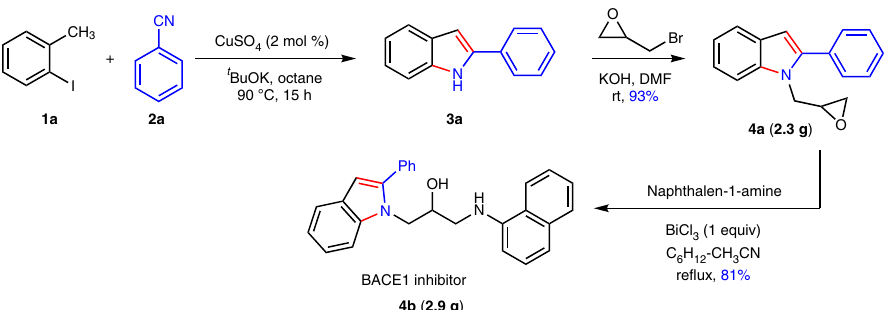
Fig. 4 Gram-scale synthesis of pharmaceuticals . a BACE1 inhibitor is synthesized from 2-iodotoluene 1a and benzonitrile 2a in gram scale using anion- radical redox relay as the key step